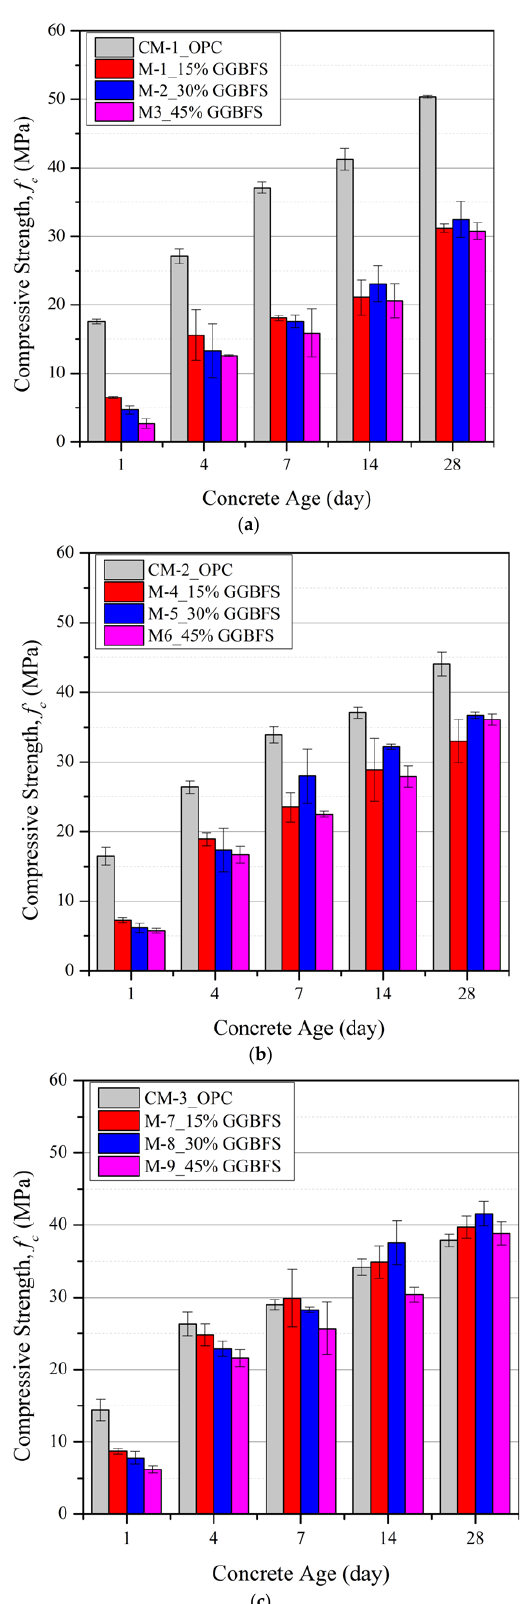
Figure 1. Concrete strength development of mortar mixtures with: ( a ) w c = 0.4, ( b ) w c = 0.5 and ( c ) w c = 0.6. The early age compressive strengths of all the slag blended mortar mixtures are sig- nificantly lower than the OPC mixes (CM-1 to CM-3). Despite this short-term negative effect, it is evident that the relative difference in strength between OPC mixes and those with GGBFS replacement reduces as the curing age increases and, for w c = 0.6, for mixes with GGBFS replacement of between 15% and 45% exceed those of the OPC mix at later ages. The increase in compressive strengths arises due to the excess Calcium Sili- cate Hydrate (C-S-H) generated in the secondary hydration process between the SiO 2 in